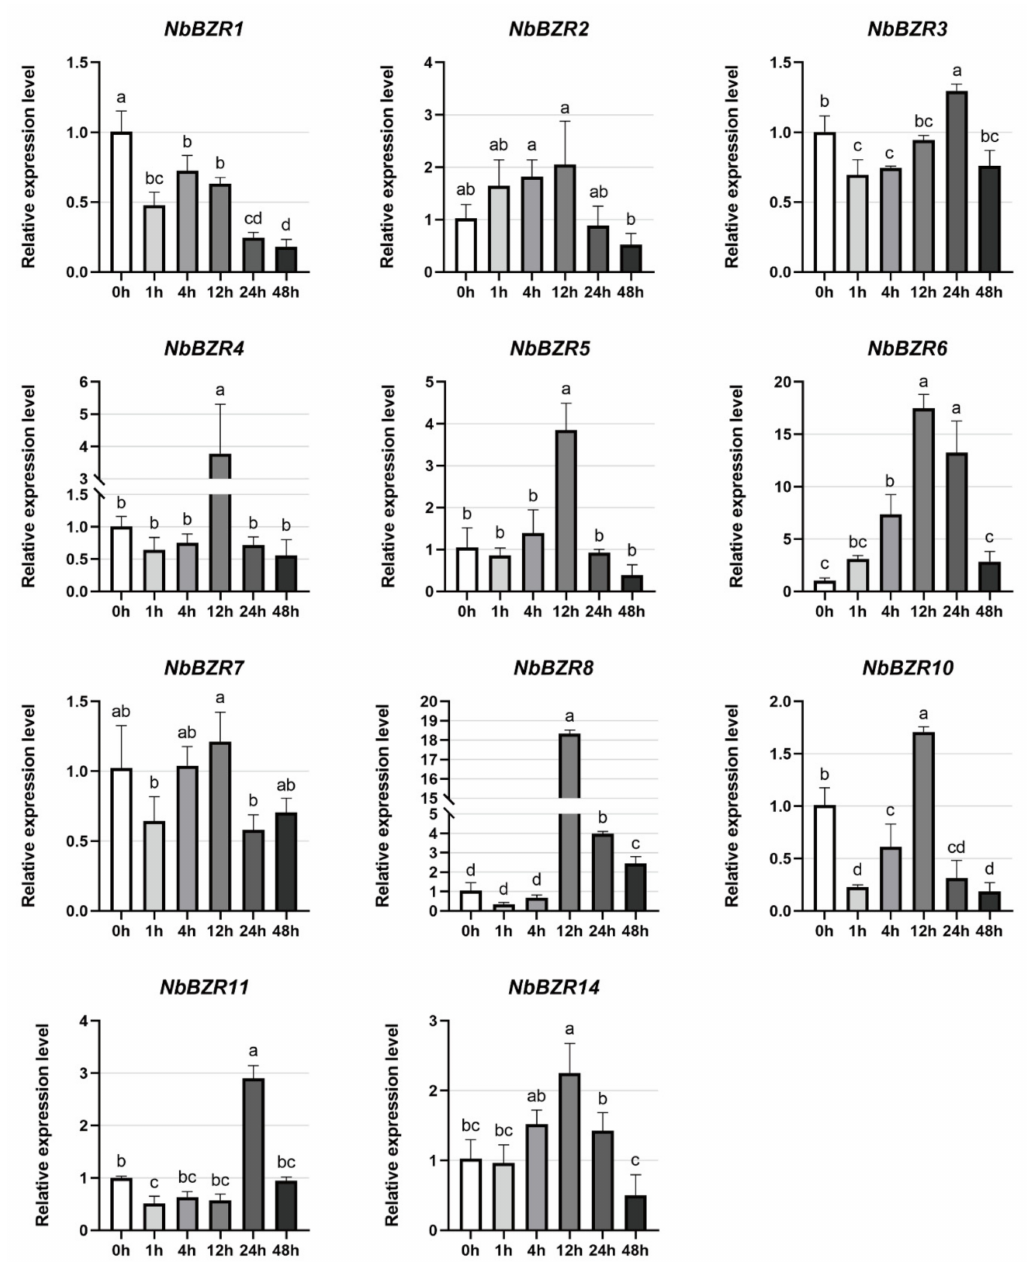
Figure 8. Expression analysis of NbBZRs after salt (0–48 h) treatment. Gene expression was normalized to control the un- stressed expression level, which was assigned a value of 1. Data represent averages of three independent experiments ± SD. Standard errors are shown as bars above columns. Different letters indicate significant differences according to Tukey’s multiple comparisons test. Columns with different marked letters are significantly different ( p < 0.05), and those with the same marked letter or share a letter are not significantly